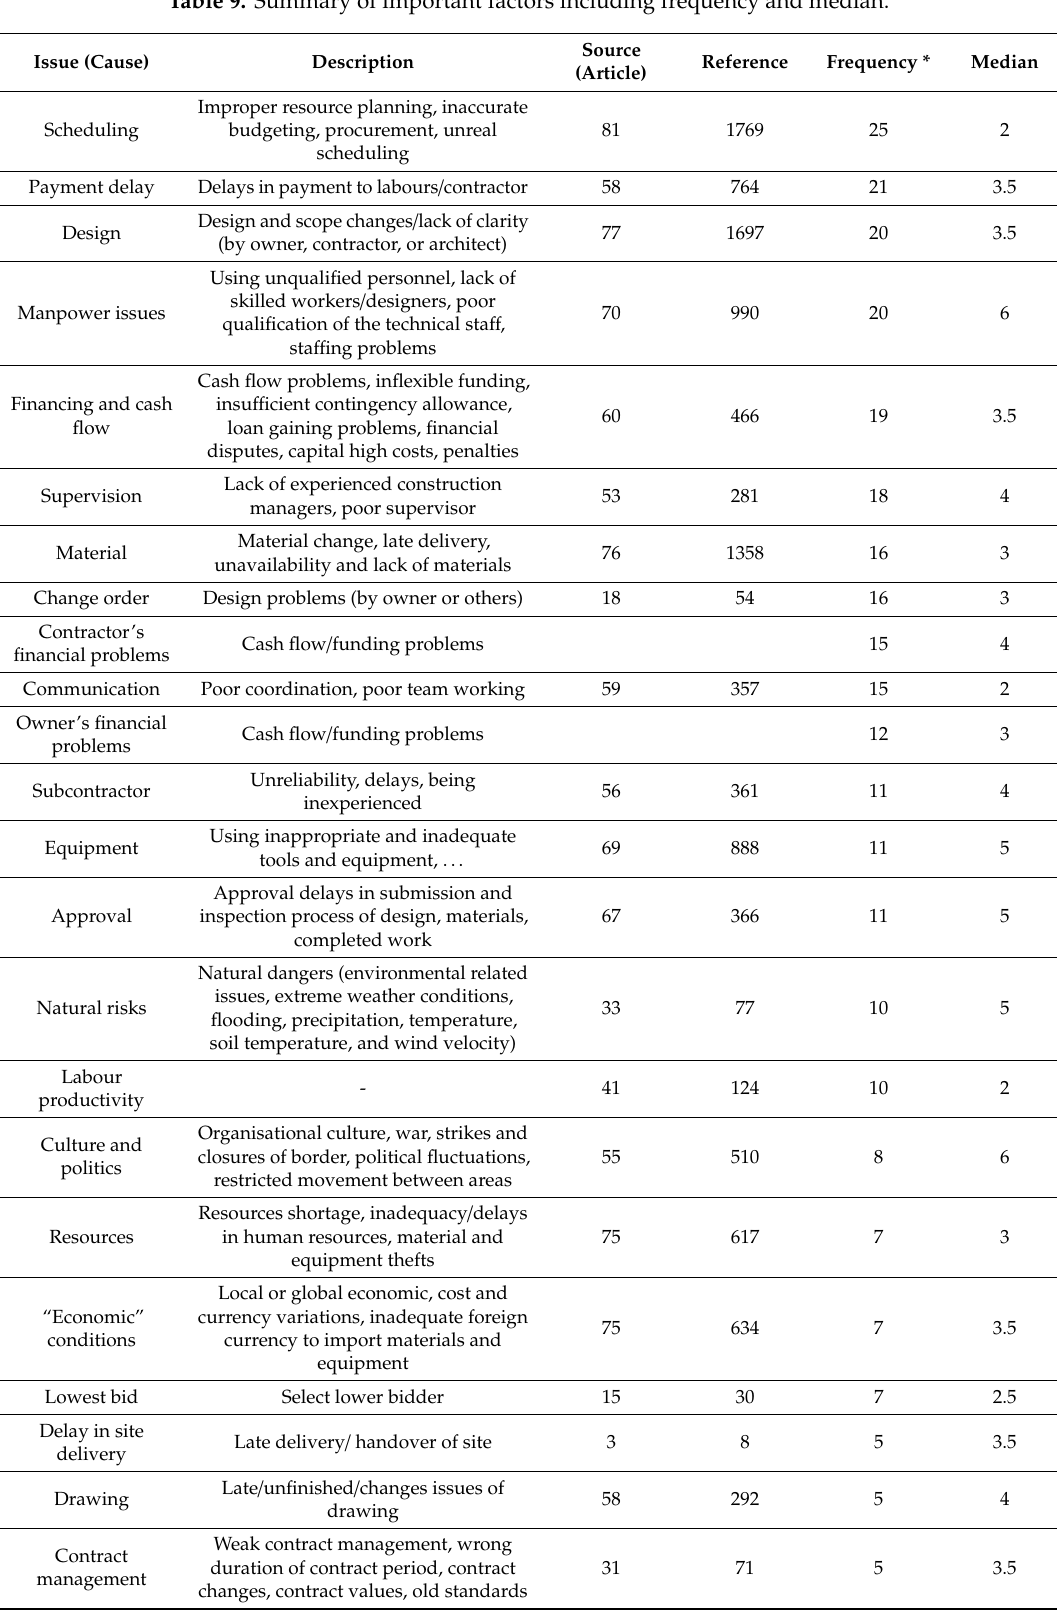
Table 9. Summary of important factors including frequency and